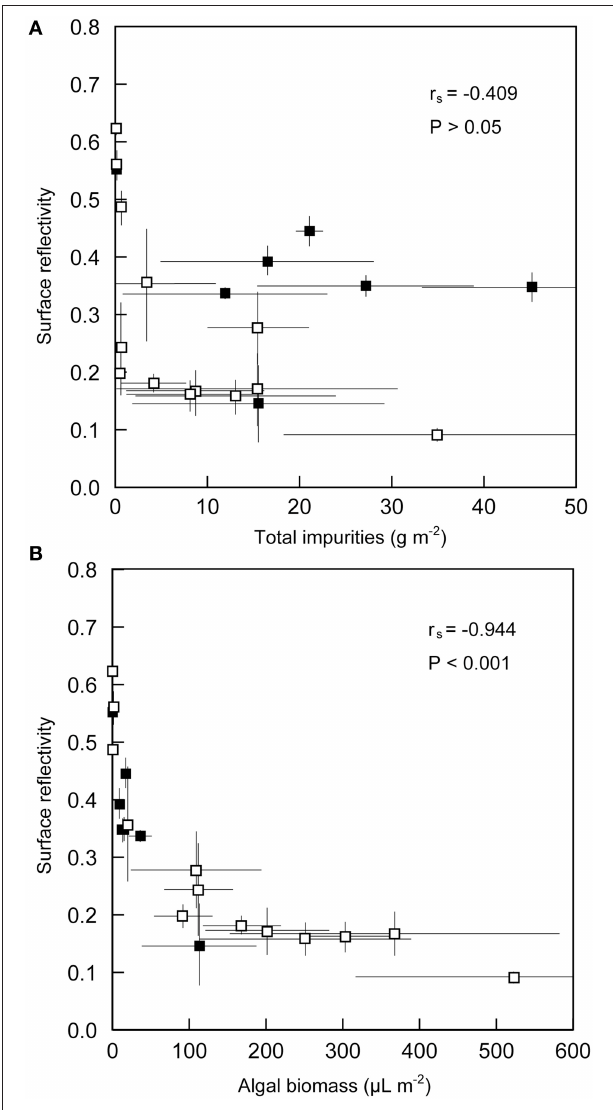
FIGURE 7 | Relationships between surface reflectivity and total impurities (A) and algal biomass (B) on the ice surfaces of Glacier No. 31. The correlation (Spearman’s rank-order correlation, r s ) was not statistically significant between surface reflectivity and total impurities (A) , but significant between surface reflectivity and algal biomass (B) . Open and solid marks indicate Sites A and B, respectively. Error bars indicate standard deviation of measurements of surface reflectivity and impurities at each